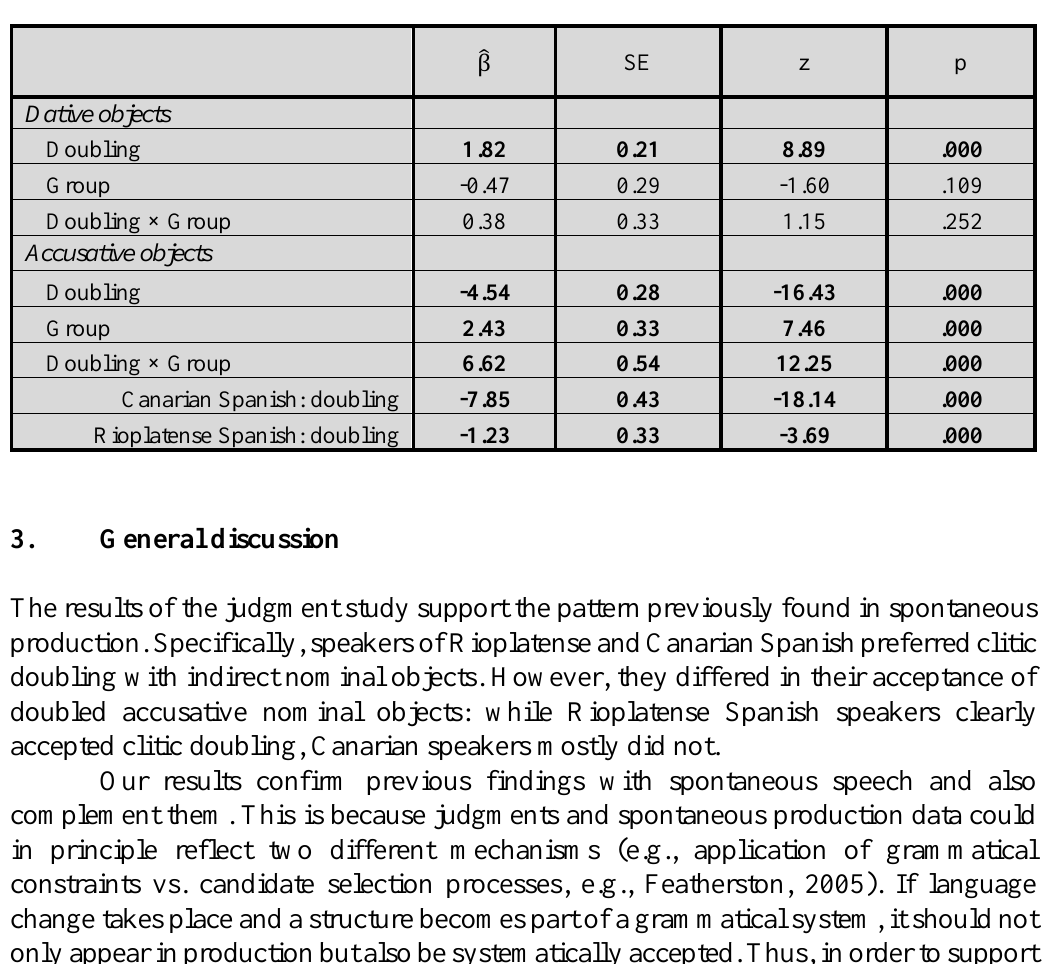
Table 1. Model results for the between-group comparisons. Model estimates are expressed in log odds and significant effects at the α = .05 level are bolded. Pairwise comparisons showed that the dispreference towards clitic-doubled accusative objects was significantly stronger in Canarian than Rioplatense speakers (compare the values of the z- coefficients in the bottom two